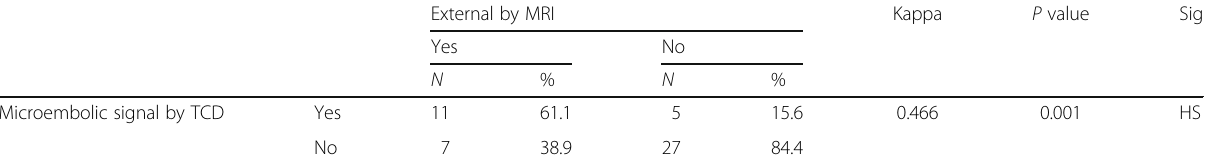
Table 5 Agreement between MRI of the brain and transcranial Doppler as regards diagnosis of watershed infarction site (external and mixed) External by MRI Kappa P value Sig Yes No N